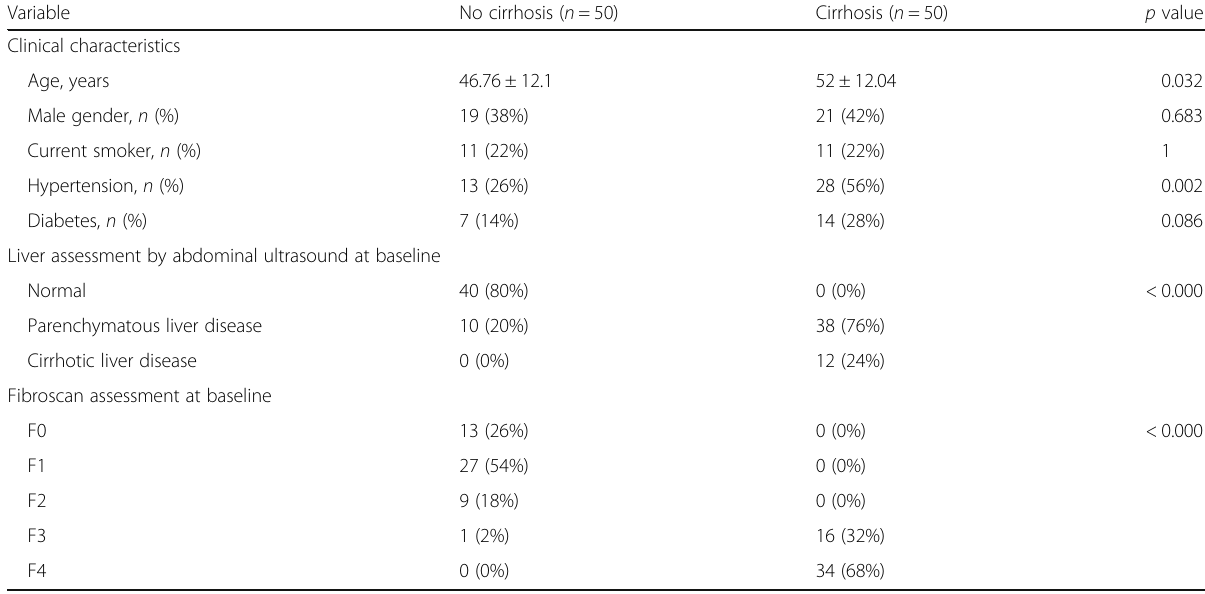
Table 1 Comparing demographic and clinical